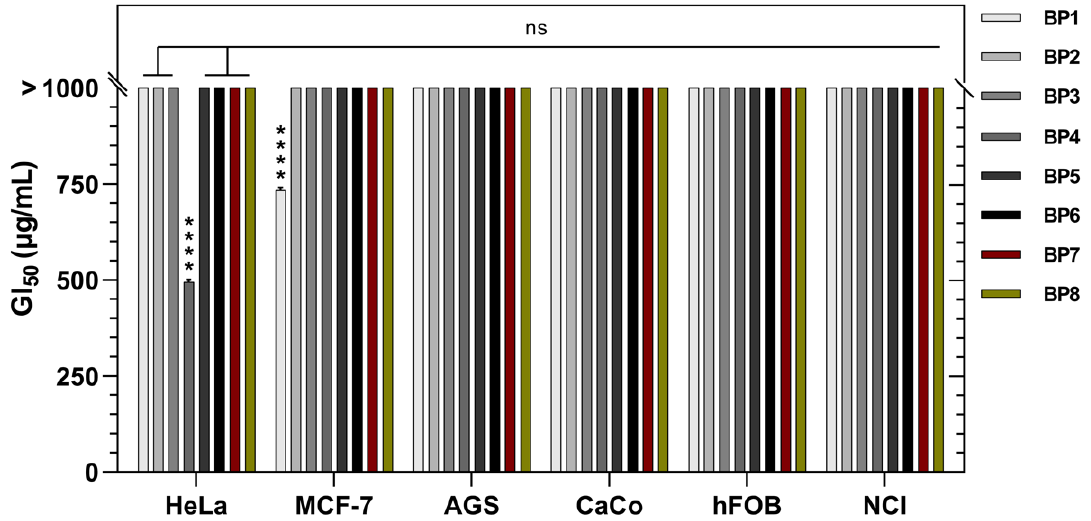
Figure 5. Cytotoxicity activity of the Moroccan bee pollen samples. ****: p < 0.0001.